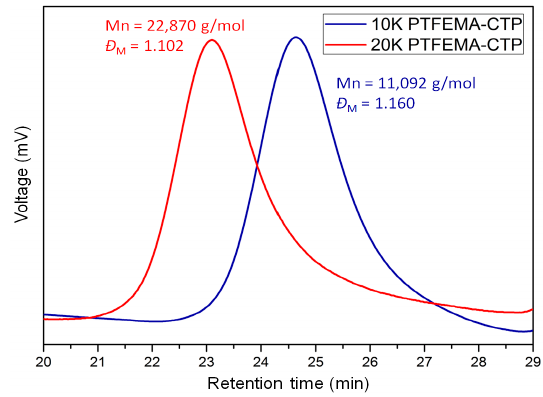
Figure 2. SEC elution curves for two different macro-RAFT agents: PTFEMA 66 -CTP (blue) and PTFEMA 136 -CTP (red).